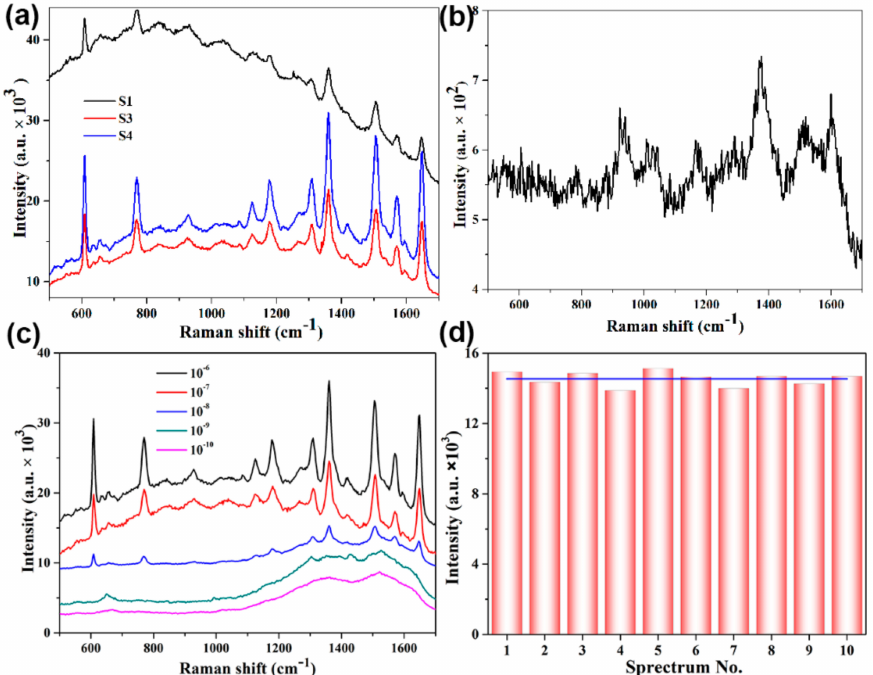
Figure 6. ( a ) SERS spectrum of different preparation conditions on SiO 2 @Ag substrate, ( b ) SERS spectrum of R6G with 10 2 M adsorbed on silicon substrate, ( c ) SERS spectrum of different concentra- tions (10 − 10 –10 − 6 M) of R6G adsorbed on SiO 2 @Ag substrate, and ( d ) Intensity distribution of R6G molecules (1 × 10 − 6 M) at the peak of 611 cm − 1 from 10 different batches of SiO 2 @Ag nanocomposite spheres